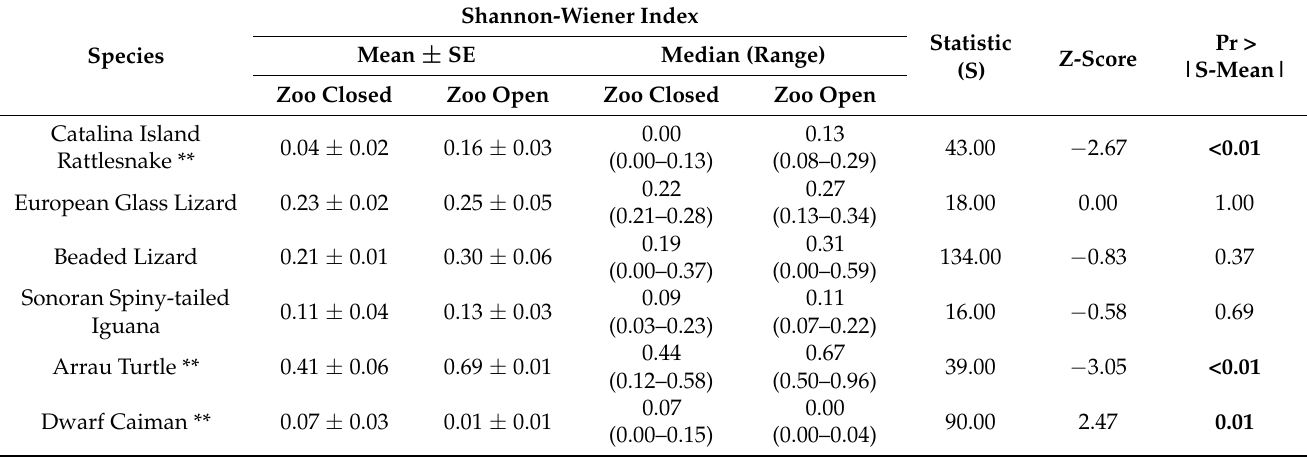
Table 7. Wilcoxon Two-Sample with Monte Carlo Exact Test Results for Shannon–Wiener Index (H). Significant differences of Pr > |S-Mean| equal to 0.01 or below are bolded with a double asterisk (**).